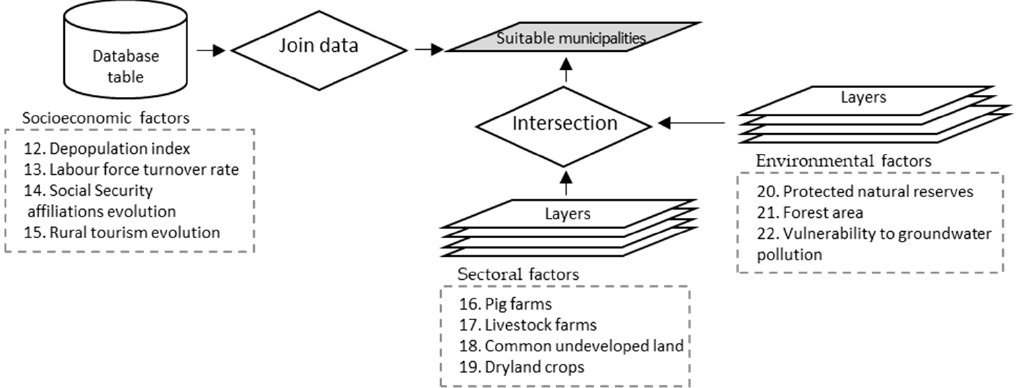
Figure 5 . GIS flowchart followed in STEP 3. Figure 5. GIS flowchart followed in STEP